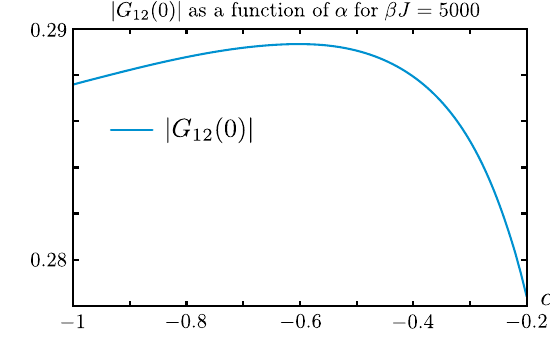
and iG for the model in LL LR FIG. 15. The expectation value of Q=N function of α for β J ¼ 5000